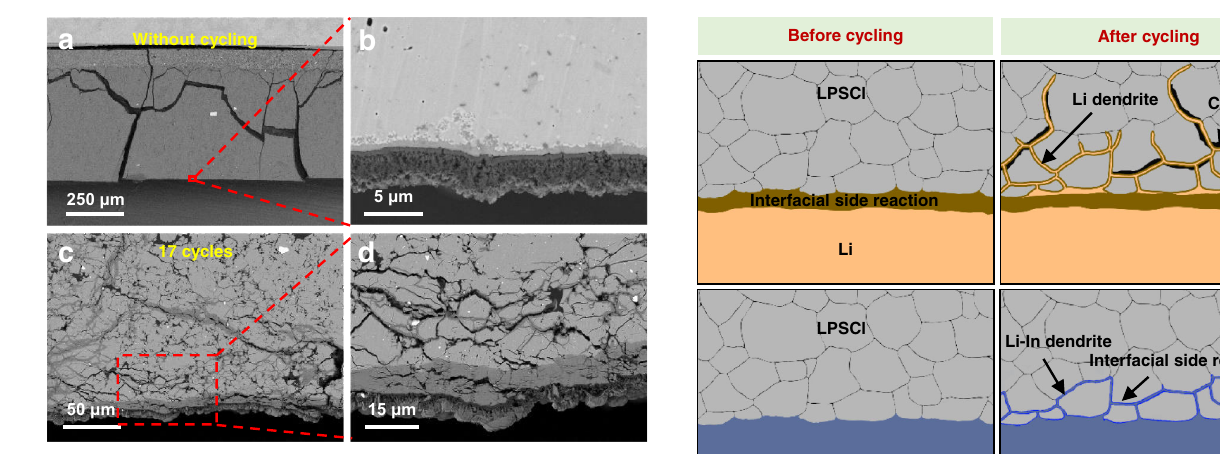
Fig. 6 Cross-sectional SEM images of the Li|LPSCl|LNO@NCM622 cell. SEM images of a the overall cross section and b magni fi ed Li-LPSCl interface without cycling. SEM images of the cell after 17 cycles at c low magni fi cation and d high magni fi cation. Fig. 7 Schematic diagram of LPSCl-Li and LPSCl-LiIn interface evolution in cells before and after cycling. The interfacial side reaction between LPSCl and Li is much severe than that of LPSCl-LiIn interface before cycling. Li dendrites vertically grow in the electrolyte layer accompanied by many cracks during cycling, while Li-In dendrites laterally grow along the pores and grain boundaries with high compactness of electrolyte